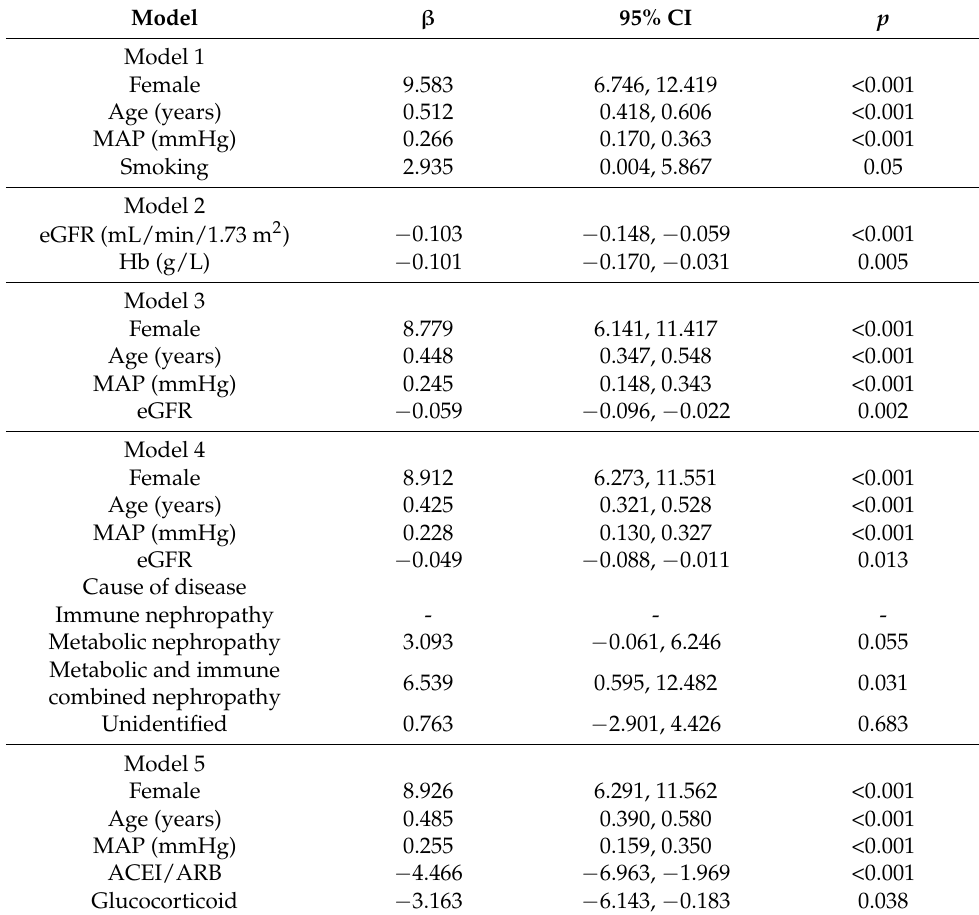
Table 4. Multivariate linear analysis of AIX@75 correlation factors in CKD